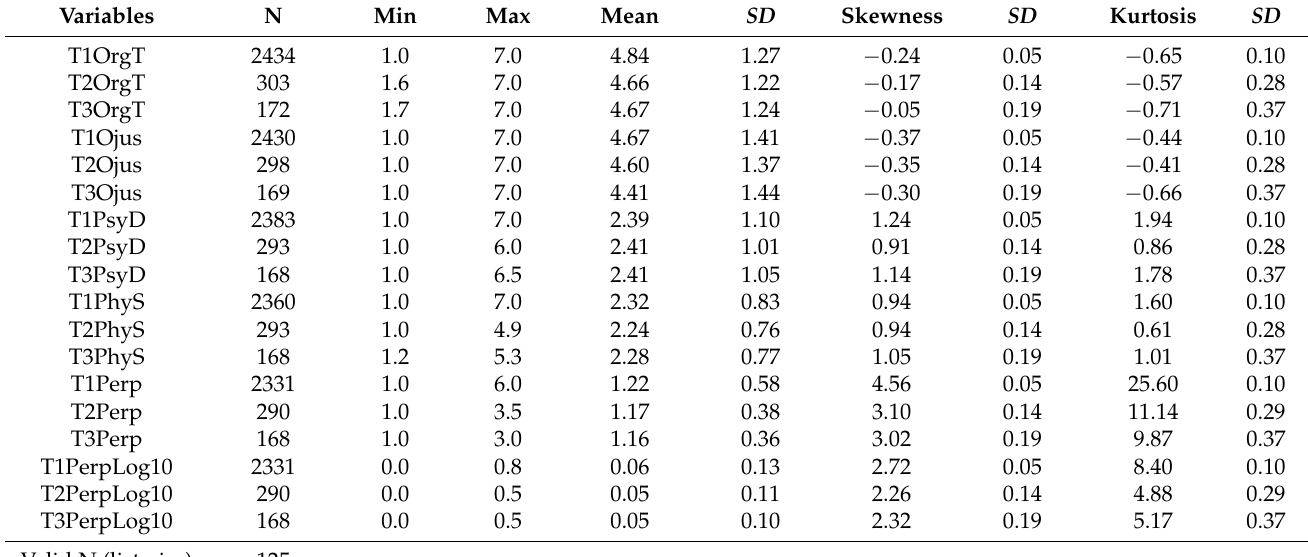
Table 2. Skewness and